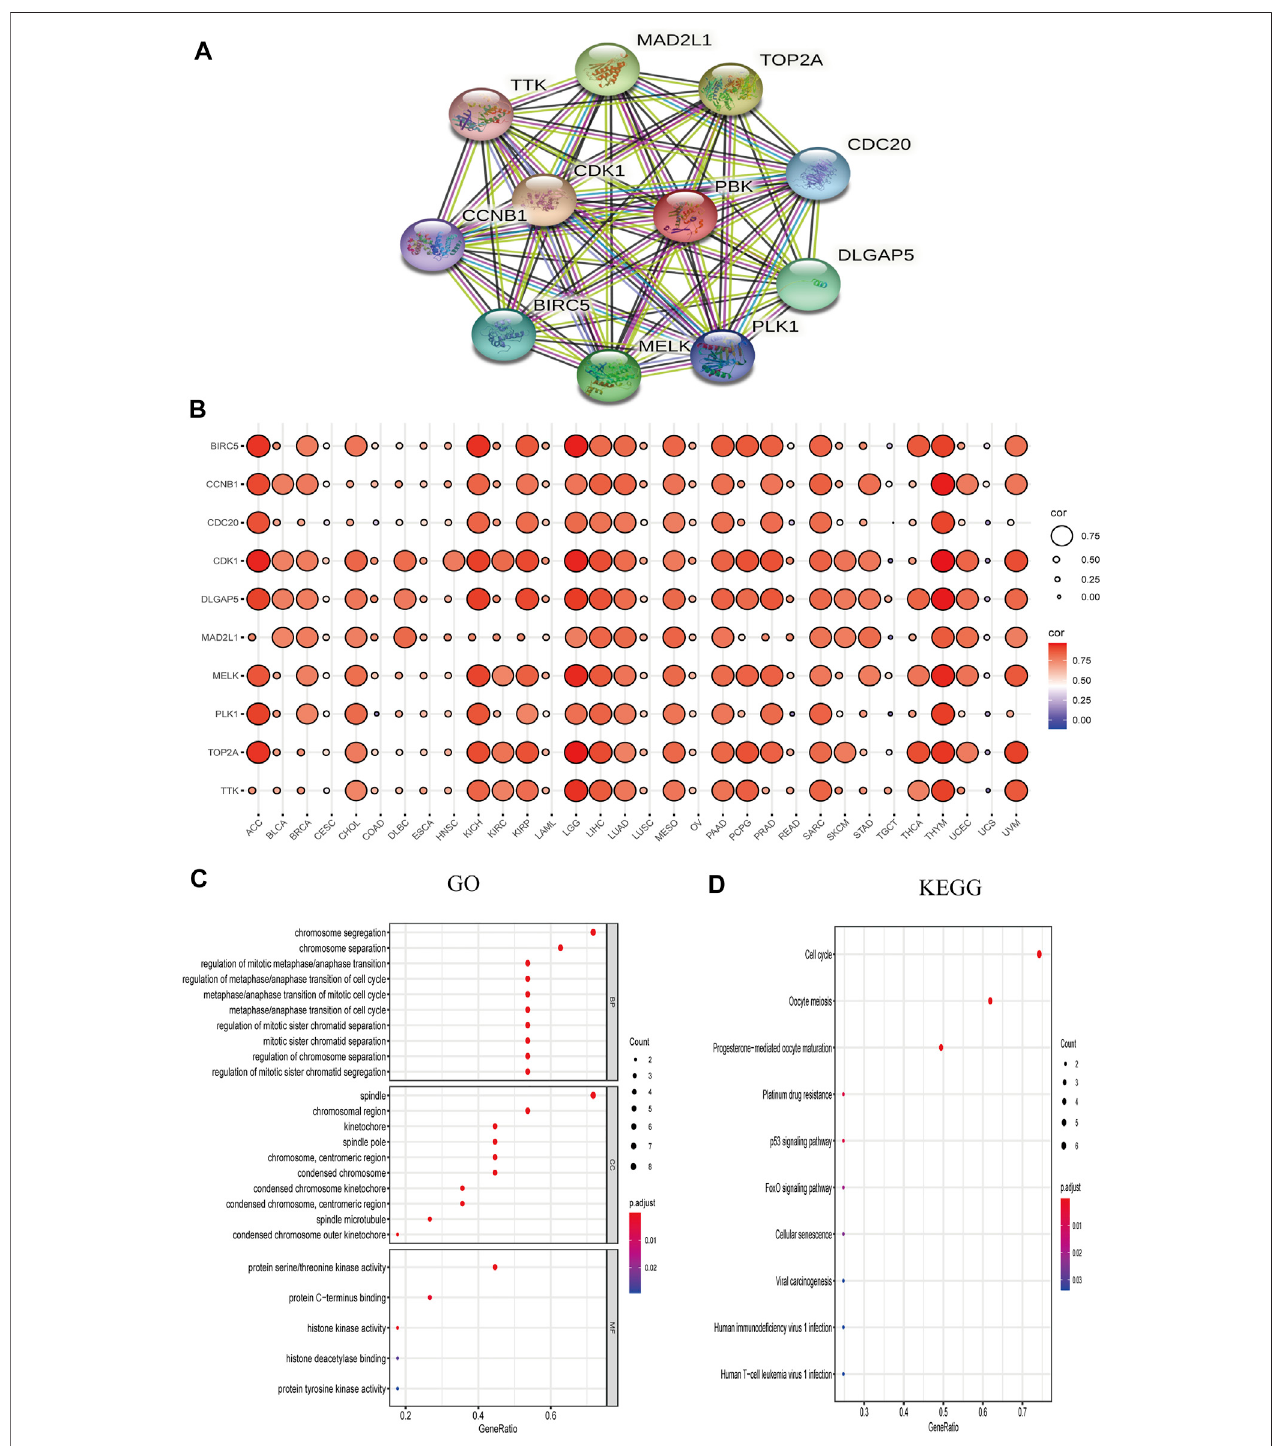
FIGURE8| PBKnetwork. (A) PBKcorrelationnetwork. (B) Correlationheatmapof10genesinteractingwithPBKin32cancers. (C,D) GO(biologicalprocess[BP], cellular component [CC], and molecular function [MF]) (C) and KEGG pathway enrichment (D) analyses of the PBK correlation network.